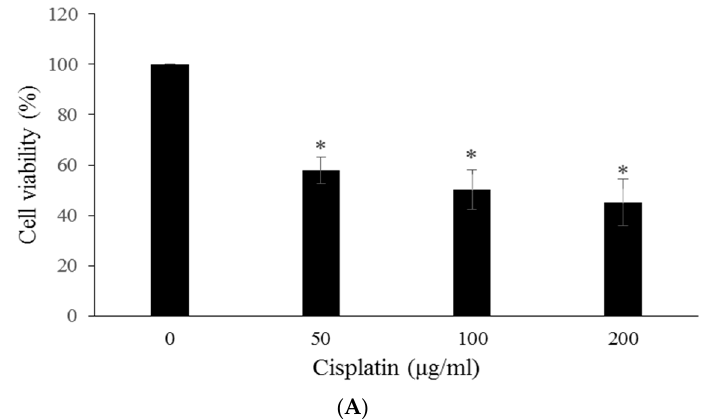
Figure 3. Cont. Figure 3. Cont.